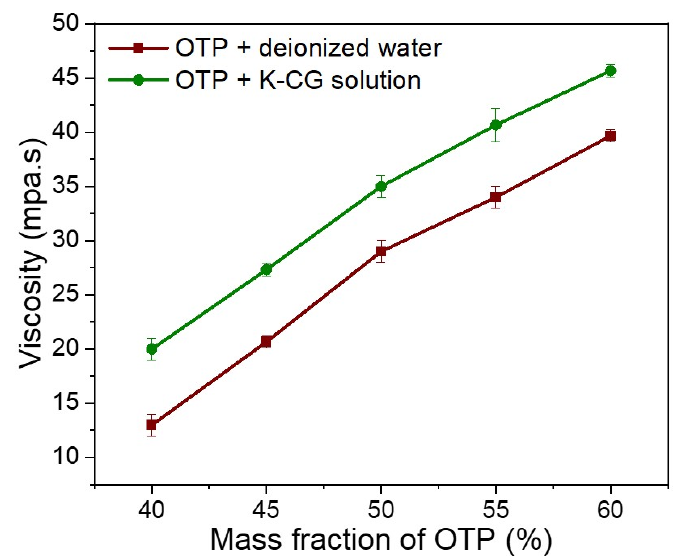
Figure 7. Viscosity in dispersing OTP in deionized water and K-CG solution.